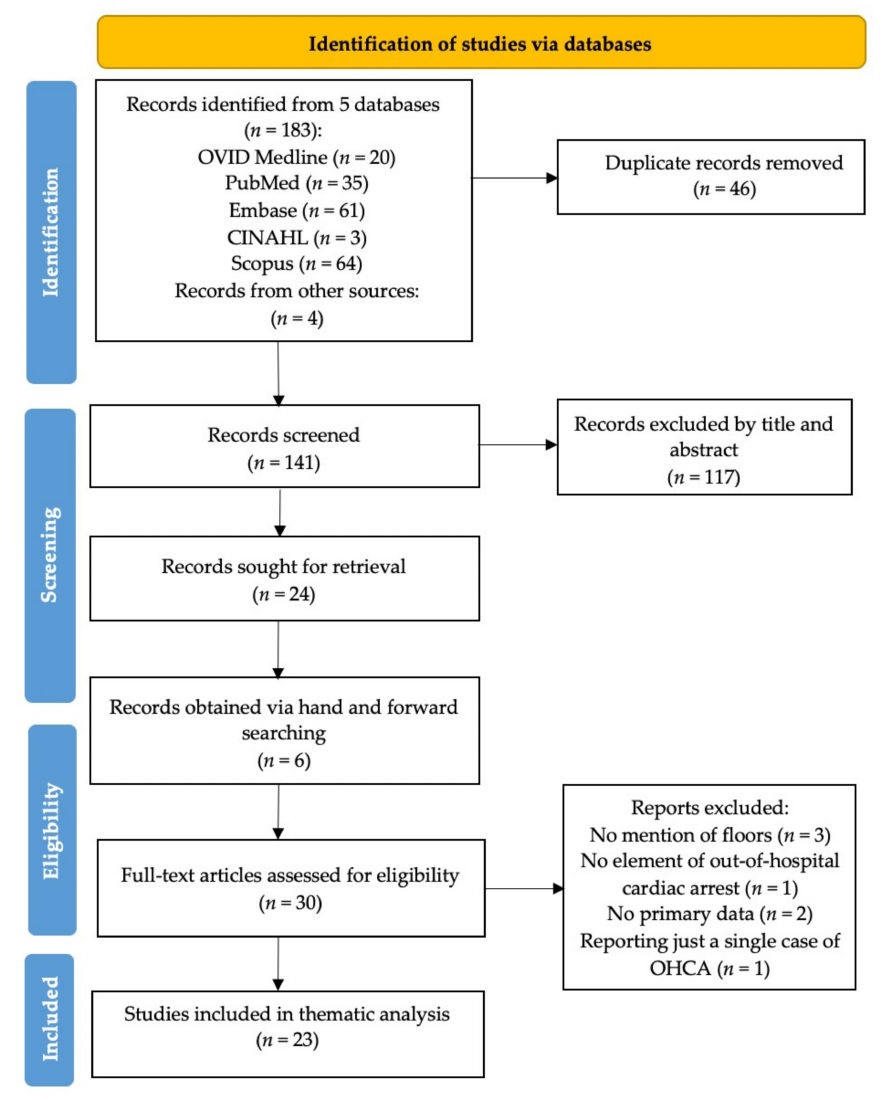
Figure 1. PRISMA flowchart illustrating the study selection process.